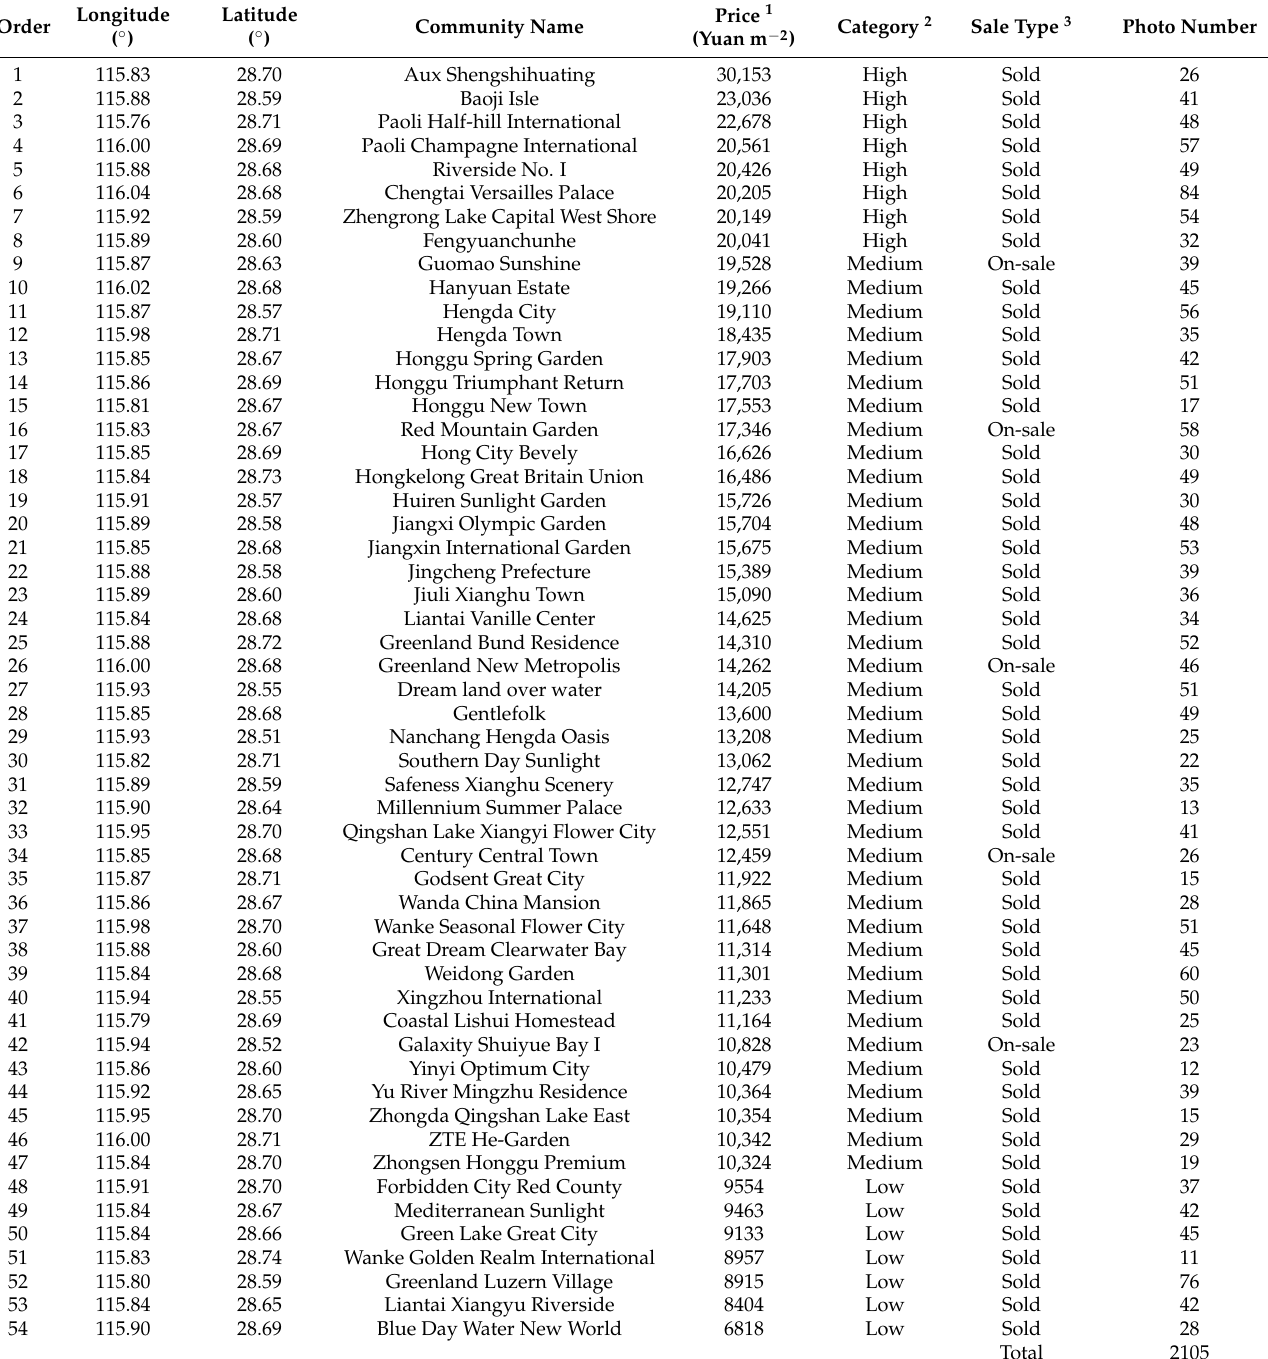
Table 1. Name and location of communities in Nanchang and the number of photos of inhabitants who took selfies and uploaded them to Sina Weibo in